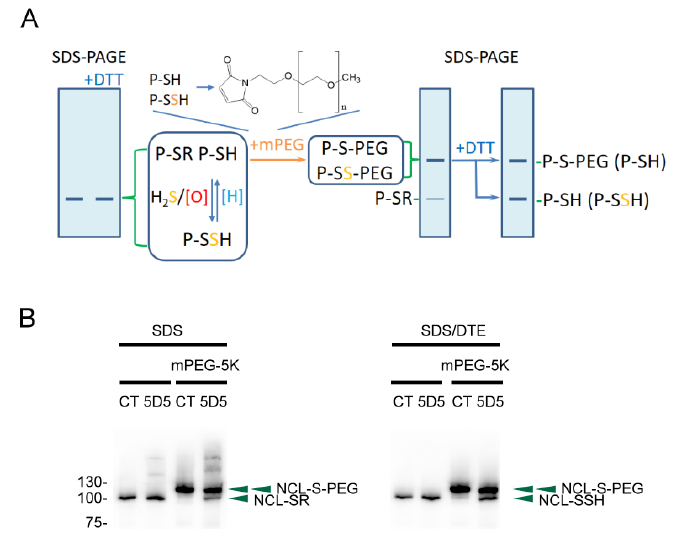
Figure 1. Tag-shift technique for determining protein S-sulfhydration. ( A ) The procedure of labeling and detection. ( B ) Nucleolin (NCL) S-thiolation and S-sulfhydration in diamide-treated FaDu cells. P-SR: S-thiolated proteins; P-SH: proteins with a thiol; P-SSH: S-sulfhydrated proteins; [O]: oxidants; [H]: reductants; mPEG: methoxypolyethylene glycol maleimide (5 kDa); DTT: